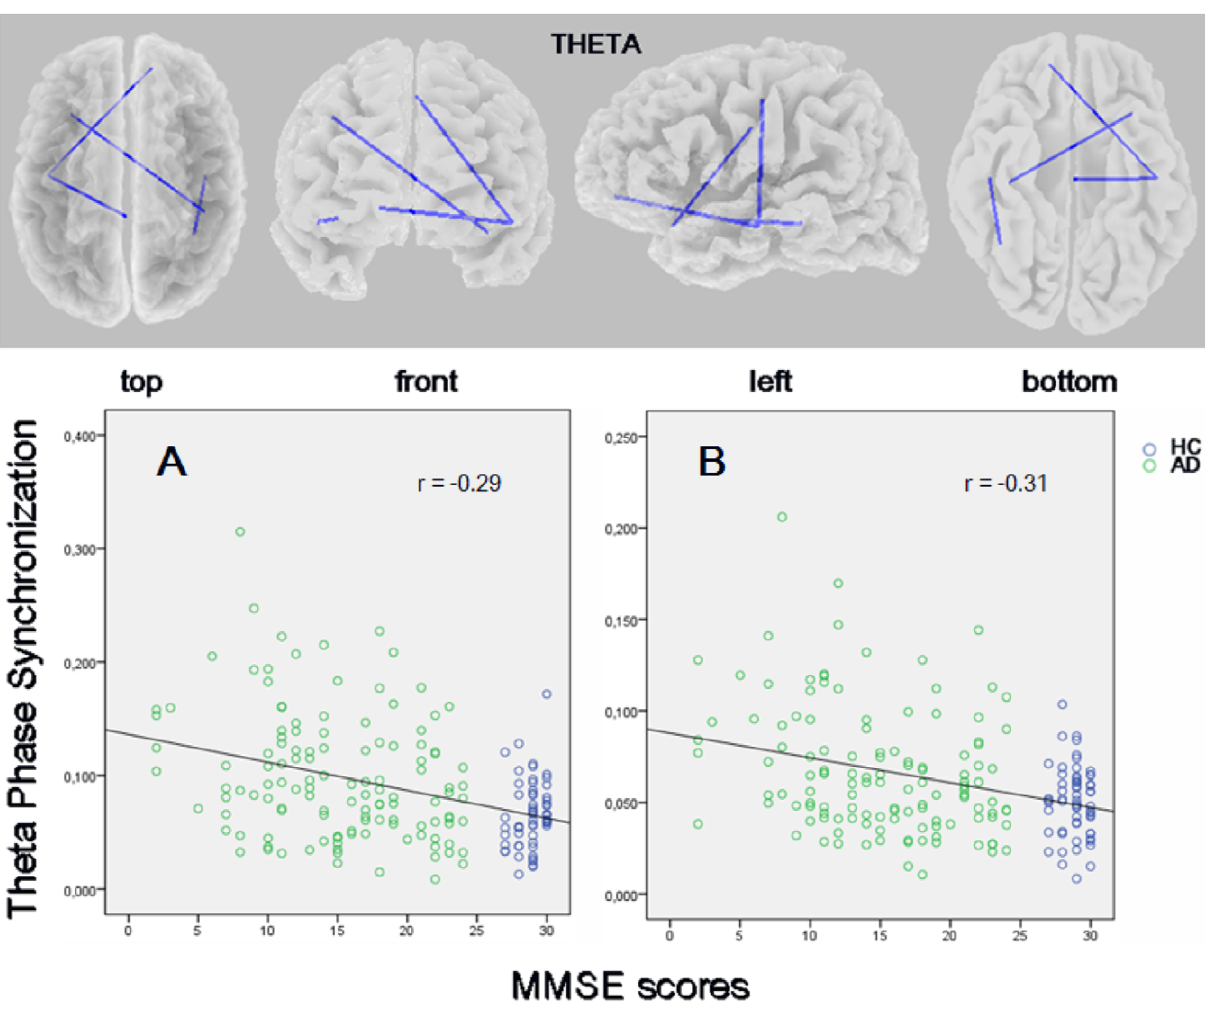
Figure 6. eLORETA wire diagram of significant correlations between theta lagged phase synchronization values and the Mini- Mental State Examination scores in patients with Alzheimer’s disease and controls (threshold: r = 2 0.27; p , 0.05, corrected). The blue color of the wires indicate a negative correlation. Results are displayed on a transparent fiducial cortical surface. The points to which the lines are connected represent the center of the ROIs. The bottom panel shows scatterplots of the strongest correlations. The results displayed correspond to the connectivity between A) left temporal-right prefrontal cortex, and B) left anterior temporal-right central cortex.